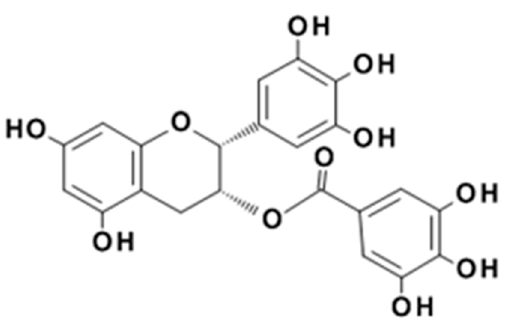
Figure 2. The chemical structure of the bioactive compound, (-)-epigallocatechin gallate